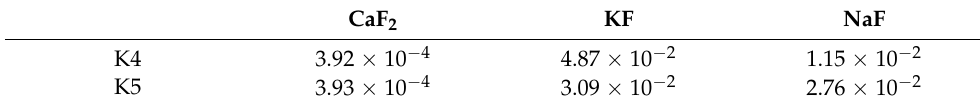
Table 4. The vapor pressure of K4 and K5 calculated at 1500 °C using FactSage 8.0 software.